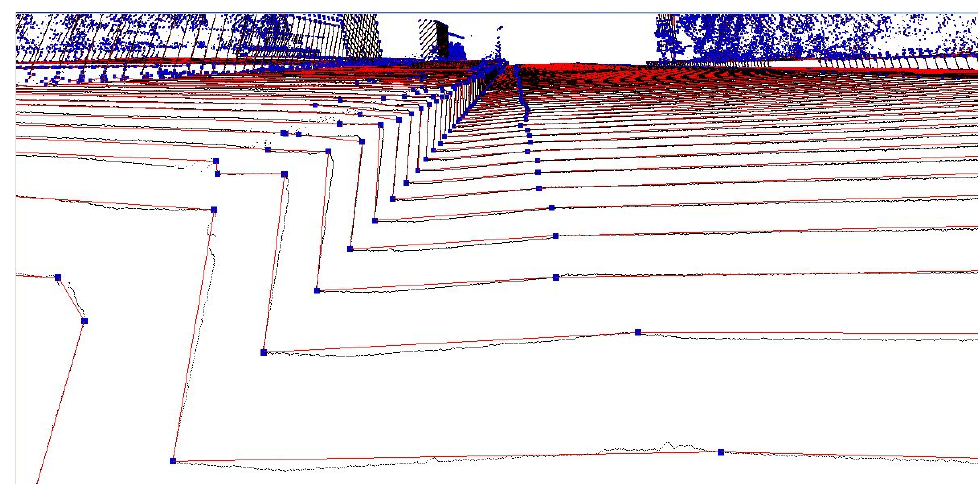
Figure 5: An example of the polyline approximating the scan line. Polylines are colored red. Large blue points are vertices of polylines. Original measured points are black dots.